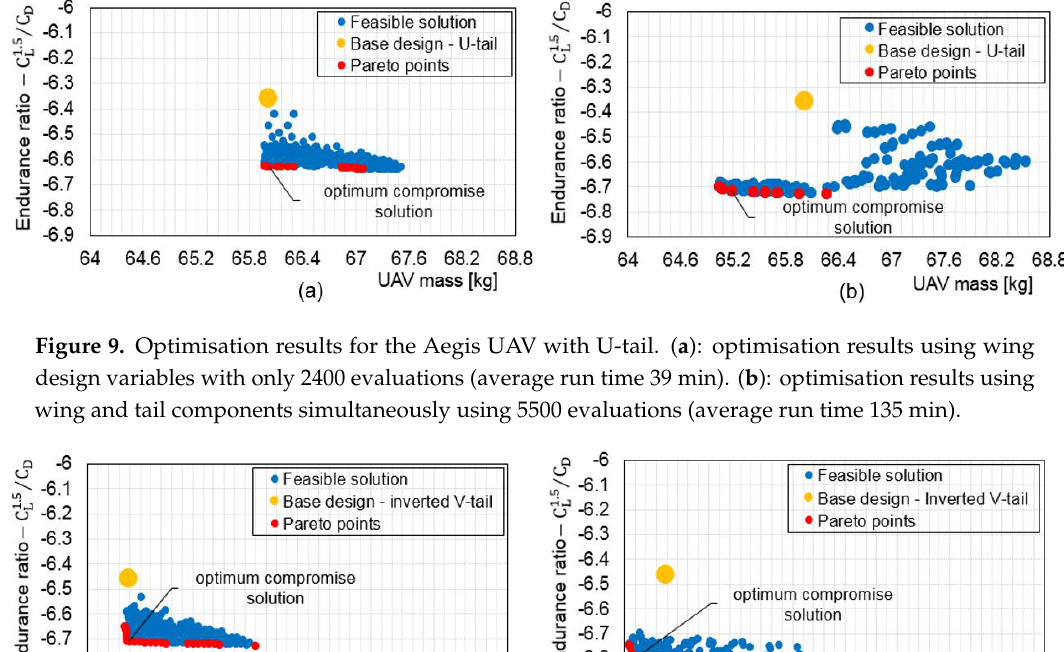
Figure 11. Left panel: comparison of the optimisation results obtained using MOTS and NSGA-II for 5500 evaluations. Right panel: the parameter setting for NSGA-II. It is obvious that both algorithms achieved almost the same quality solutions, but the non- dominated solutions obtained by NSGA-II have greater variance. On the other hand, regardless of the optimisation and search techniques used by each algorithm, the run-times for MOTS and NSGA